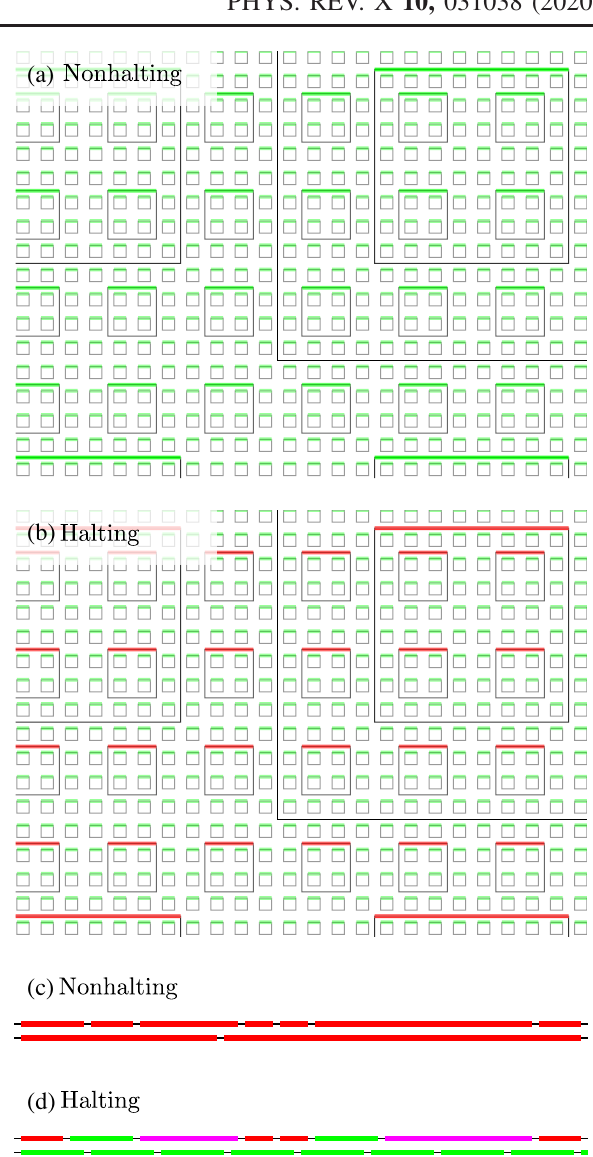
FIG. 4. 2D Robinson tiling construction with instances of a Turing machine running on the upper edges of the fractal rectangles. Each edge represents the available tape for the Turing machine. In the nonhalting case (a), there will never be any halting penalty, no matter how much tape there is available. In the halting case (b), there is a threshold side length after which each rectangle larger than the threshold contributes a penalty (red), which yields a small but nonzero ground-state energy density; the ground-state energy diverges. In the 1D case, we show the segments emerging from the marker Ham- iltonian from Sec. IV (cf. Fig. 2). In the nonhalting case (c), no segment length is long enough to contain the entire computa- tion; all segments obtain a penalty (red). In the halting case (d), there is an ideal segment length (green) with just enough tape for the TM to halt; as per Fig. 3, this segment has the maximum possible bonus. Segments too short (red) contribute a net energy penalty, whereas segments too long (magenta) do contribute a bonus, yet not one as large as the optimal segment